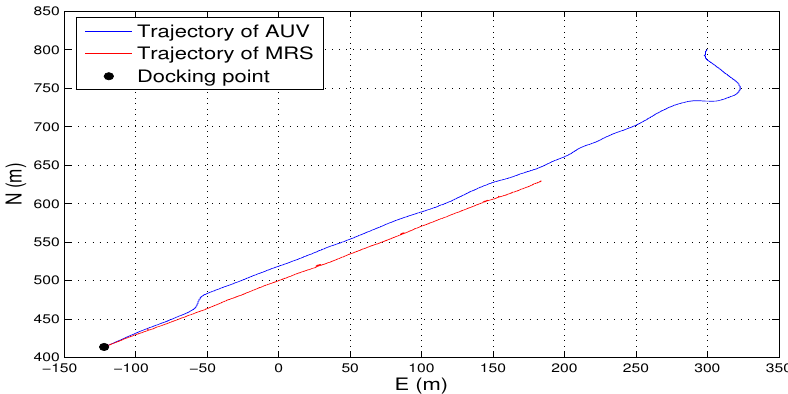
Figure 12. Trajectories of AUV- II and MRS recorded by IMU in AUV- II homing to